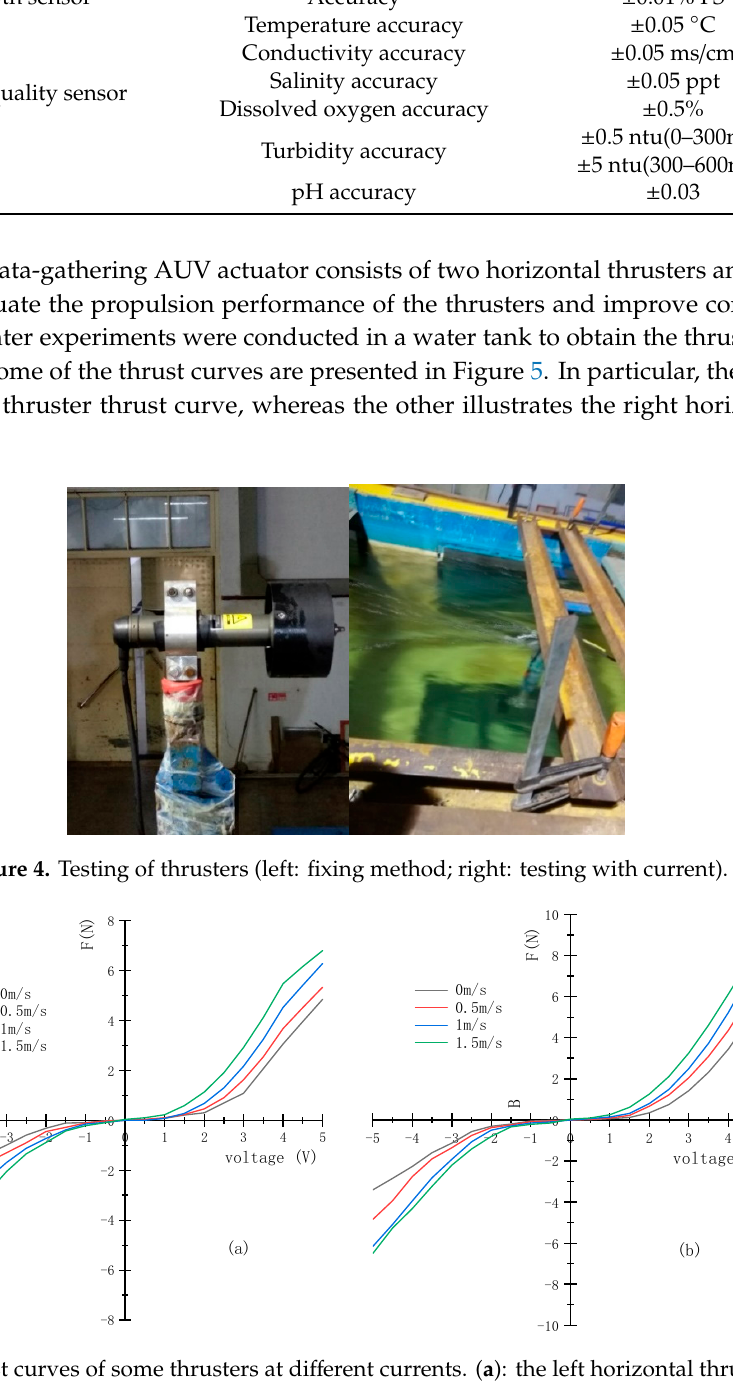
Table 2. Specifications of the applied sensors.